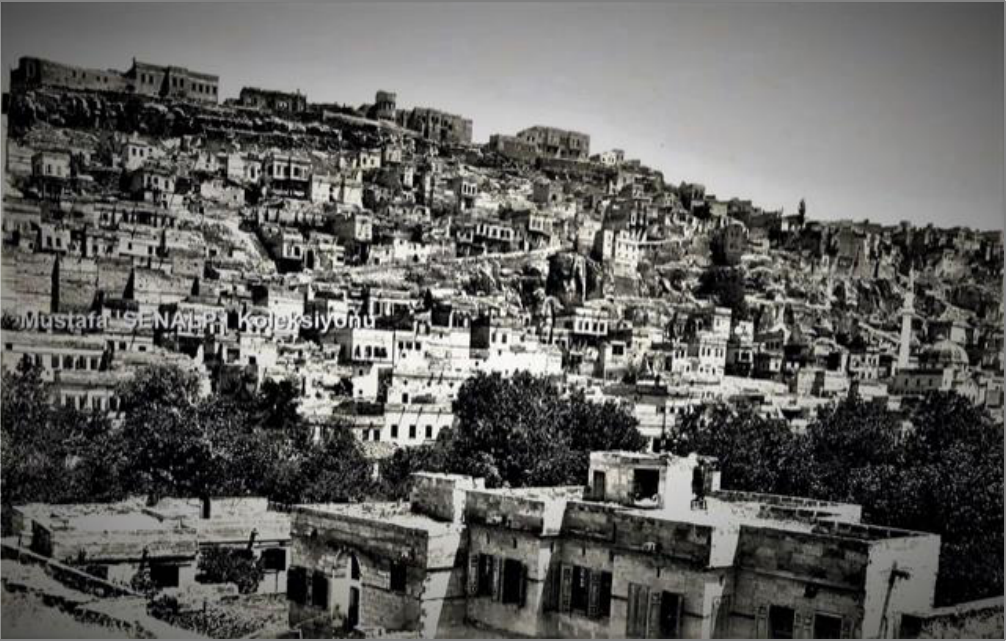
Figure 7 KaramanBayırı and Yukarı Talas ( Şenalp, M.,